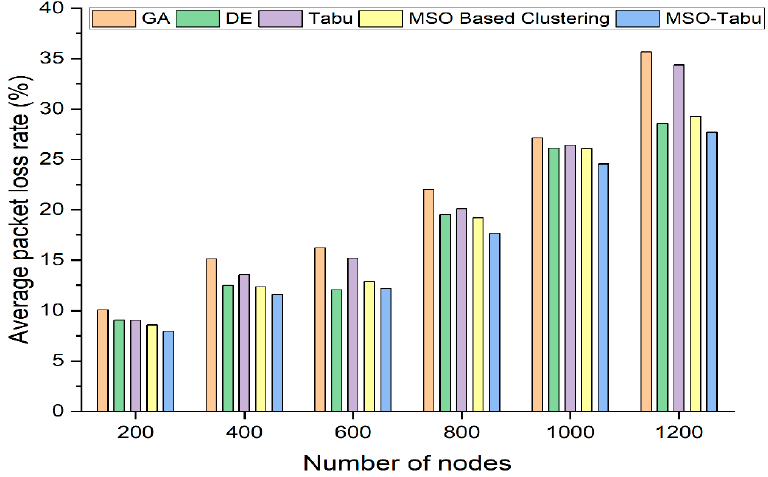
Figure 3. Average Packet Loss Rate for MSO-Tabu.